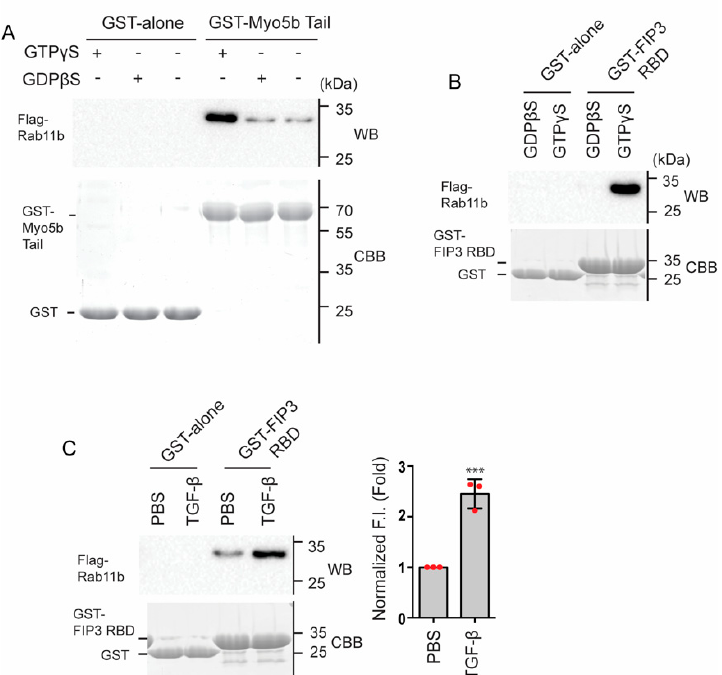
Figure 11. Effect of TGF- β on the activation of Rab11b in HPMCs. ( A ) GST-pull down assay showing the binding of GST- Myo5b Tail (M5b) (853 − 891 a.a.) to Flag-Rab11b. The pulled down sample with GST-beads were subjected to SDS page and visualized with CBB or Western blotting (WB) using anti-flag antibody. Pre-incubated Rab11b with GTP γ S, but not with GDP β S enhanced the binding to GST-M5b Tail. Full-length blots were presented in Supplementary Figure S5. ( B ) GTP binding to Rab11b enhances the binding with GST-FIP3-RBD (Rab11 binding domain). The pulled down pro- teins with GST-beads were subjected to SDS page and visualized by CBB or Western blotting using anti-flag antibody. Full-length blots were presented in Supplementary Figure S5. ( C ) TGF- β stimu- lation activated Rab11b in HPMCs. HPMCs were stimulated with or without TGF- β . The cell lysates were incubated with GST-FIP3-RBD or GST alone, then subjected to GST pull-down assay. The pulled down proteins were subjected to SDS page and visualized with CBB or Western blotting using anti-Rab11b antibody. Left, representative western blot; Right, statistical representation of Western blot signal intensities of Flag-Rab11b ( n = 3, mean ± SD). *** p < 0.001 vs. PBS. Full-length blots were presented in Supplementary Figure S5. The red spots in bar graph displays the distribu- tion of data points.